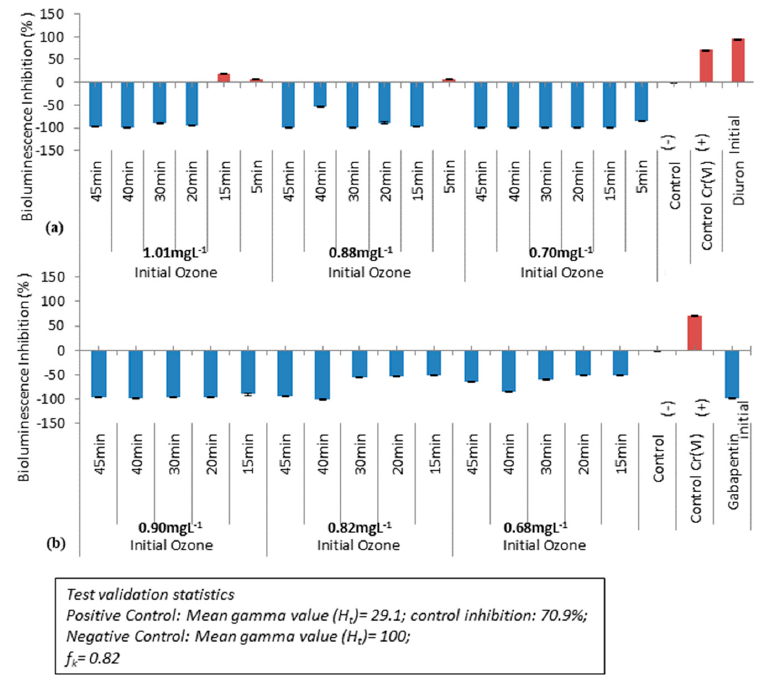
Figure 3. Bioluminescence inhibition before and after ozonation treatment (Microtox acute toxicity ( a ) diuron, ( b ) assay): ( a ) diuron, ( b ) gabapentin.